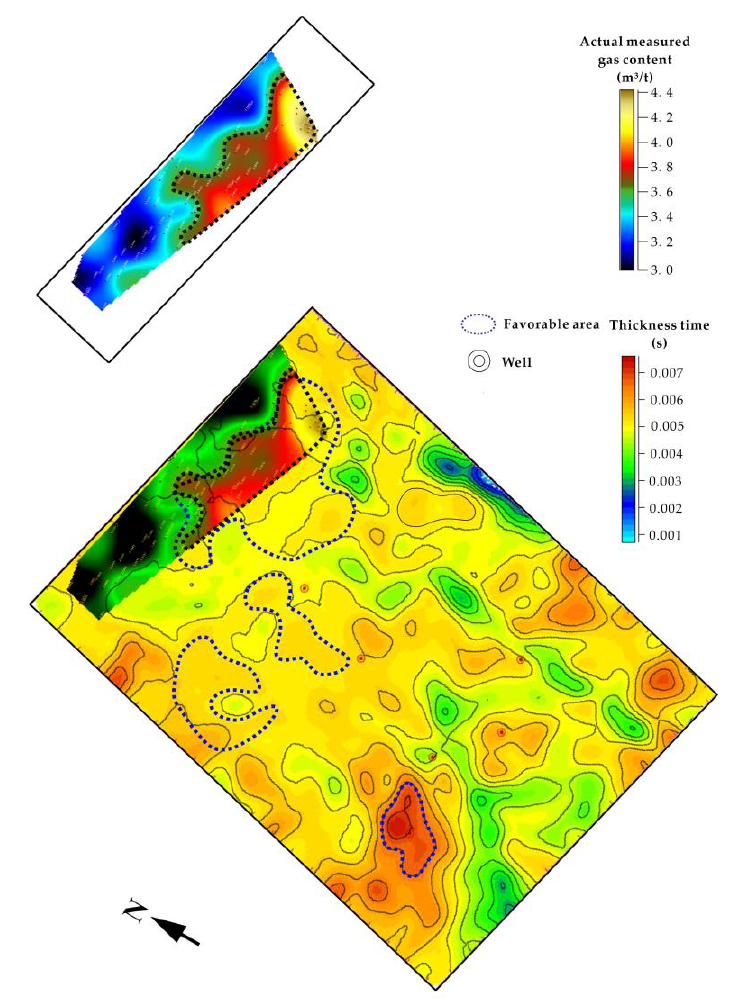
Figure 17. Comparison between actual measurement and prediction results of CBM content.